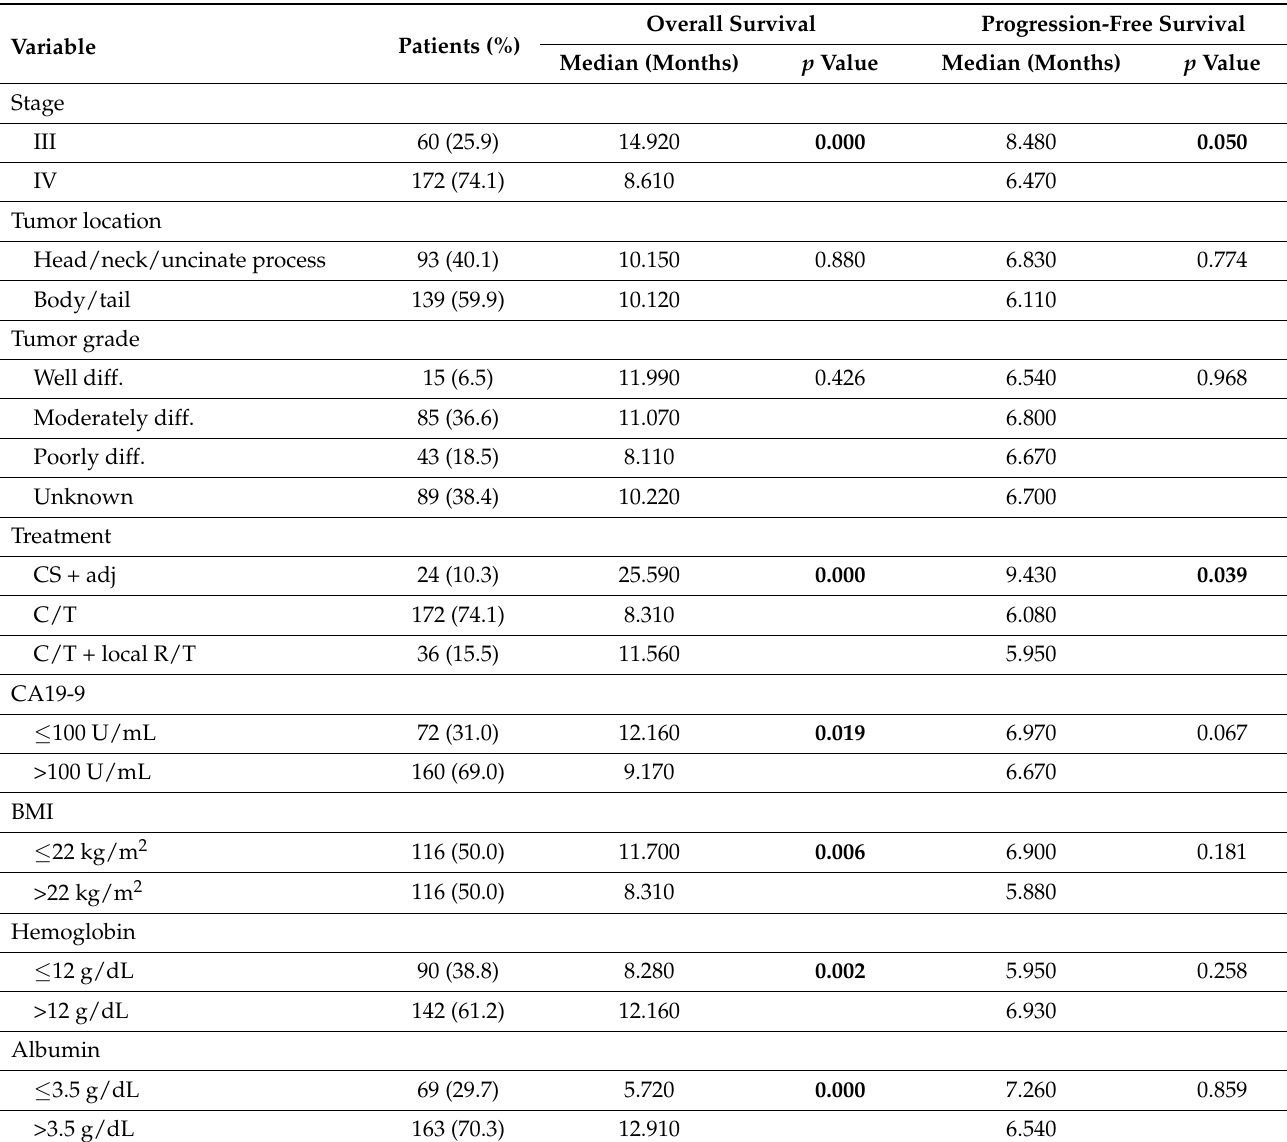
Figure 2. Patients in the non-CC group had significantly better OS and PFS than those in the CC group. The median OS (mOS) and PFS time (mPFS) of the patients without CC was 17.050 (95% CI: 10.504–23.596) and 8.210 (95% CI: 6.578–9.842) months, whereas mOS and mPFS of patients with CC were 9.430 (95% CI: 8.006–10.854) and 5.950 (95% CI: